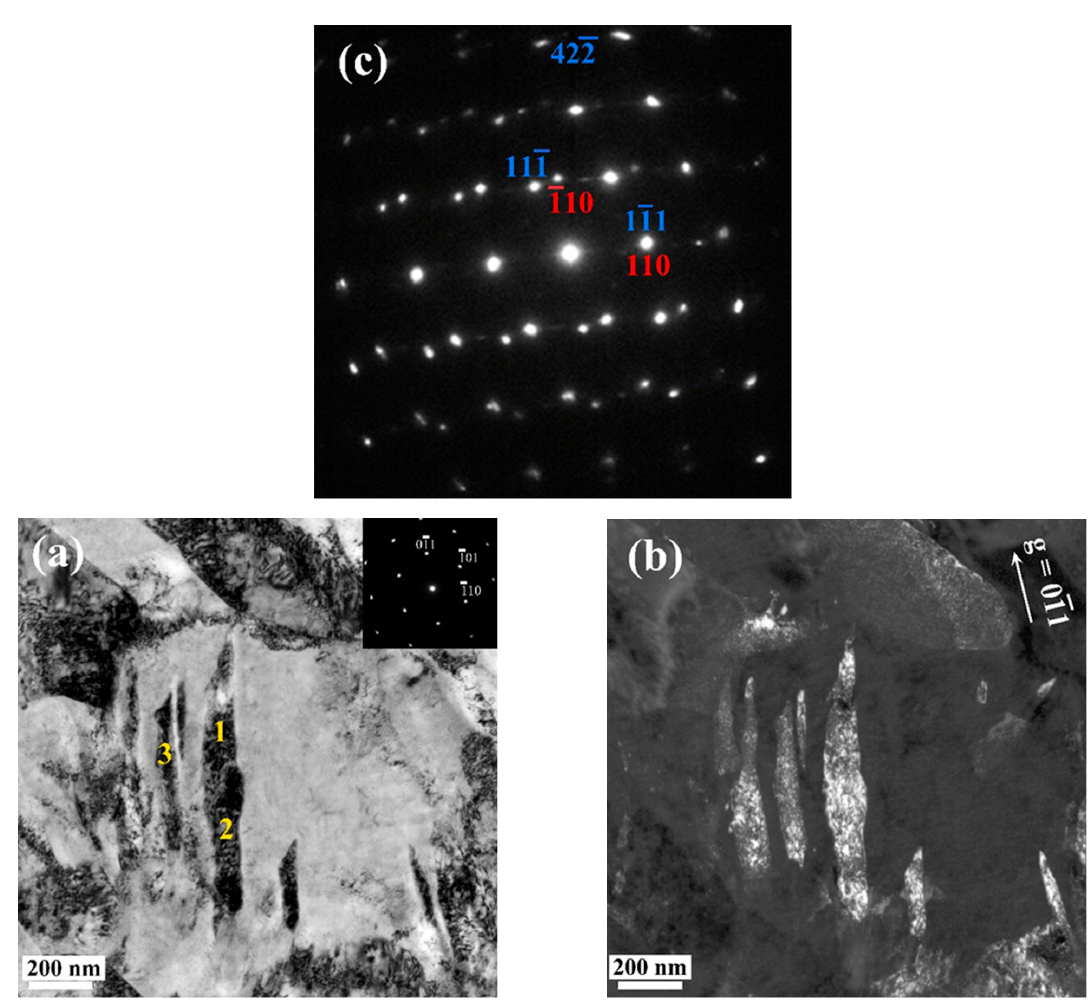
Figure 7. TEM ( a ) bright field ( b ) dark field images from a specimen tested at 175 ◦ C to an elongation of 30%. The morphology of DIBs is the typical sheaf morphology of conventional bainite. EDS results from positions 1 to 3 are given in Table 2. The insert SADP in ( a ) is from the beam direction [111] of bainite. ( c ) The SADP was from the area marked by the dotted circle in ( a ) and tilted to the new beam direction. SADP from an area included both DIB and austenite matrix. This SADP is from the beam direction [001] of bainite and [011] of austenite. The red and blue indexes are for bainite and austenite, respectively. Table 2. EDS results from positions 1, 2 and 3 marked in Figure 7a. The value of each element is a result of normalizing with the sum of the four elements to